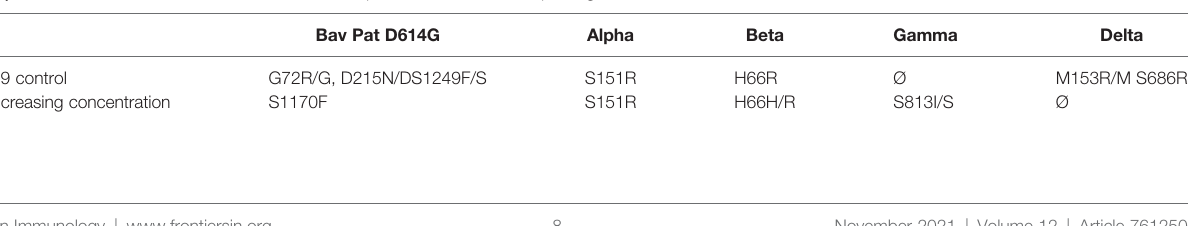
TABLE 2 | Amino acid substitutions in the SARS-CoV-2 Spike detected after fi ve passages in Vero E6 cells with or without addition of